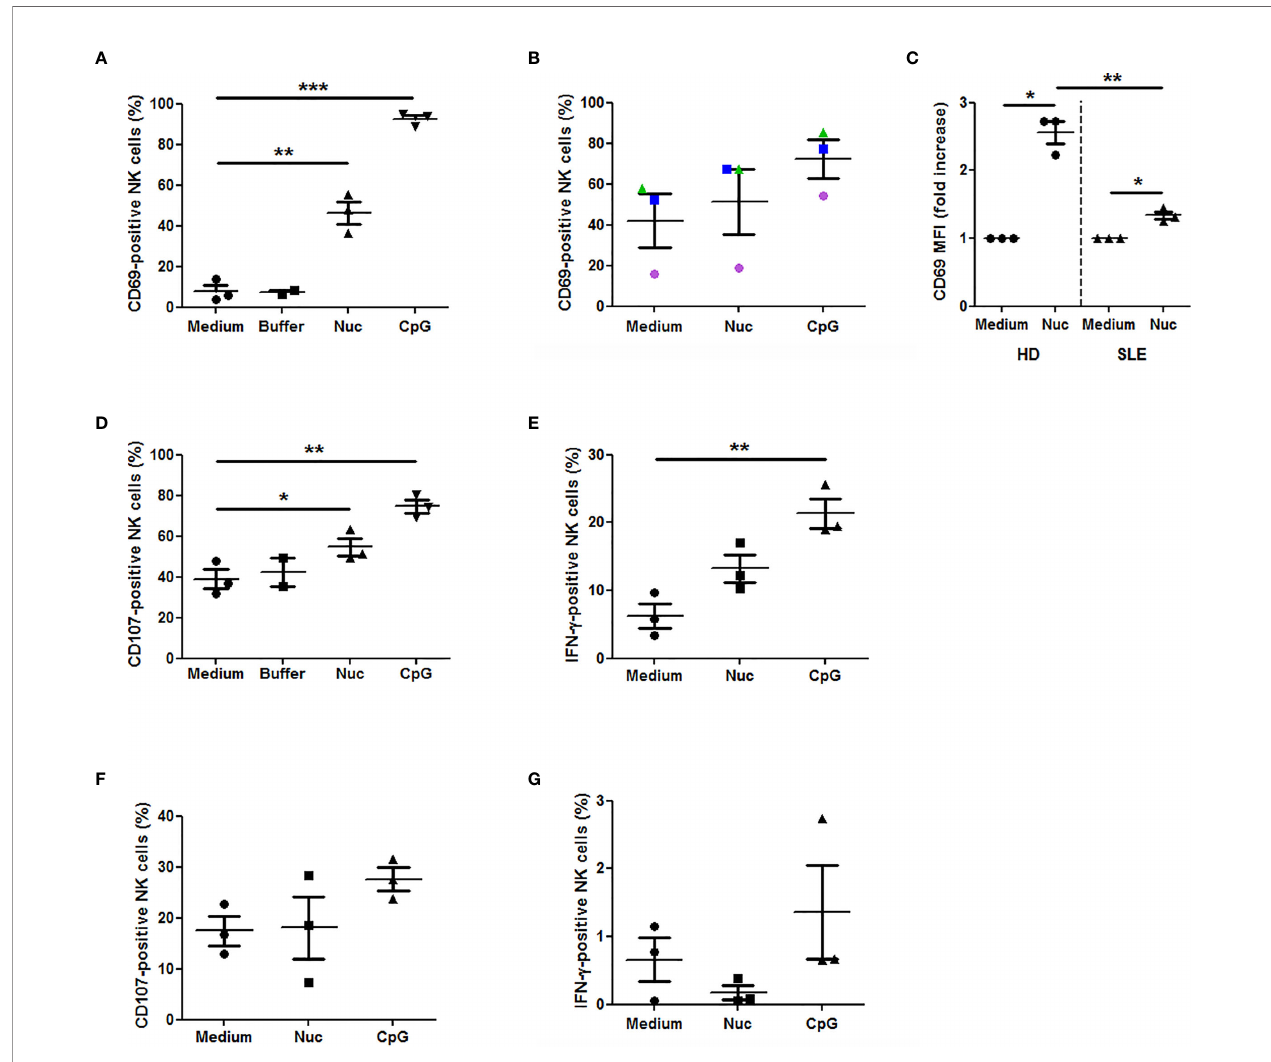
FIGURE 7 | Extracellular chromatin triggers NK cell activation in PBMC. PBMC were isolated from healthy individuals (n = 3, A, C – E ) or SLE patients (n = 3, B, C, F, G ) and cultured in medium alone or supplemented with puri fi ed nucleosomes (Nuc, 25 µg/ml), its puri fi cation buffer or a TLR9 agonist (a synthetic oligonucleotide containing unmethylated CpG motifs, CpG). NK cell activation was analyzed by fl ow cytometry, gating on CD3 - CD56 + cells as in Supplementary Figure 2 . (A – C) CD69 expression by NK cells from healthy individuals (A, C) or SLE patients (B, C) . PBMC were cultured without K562 cells. The percentages of CD69-positive NK cells (A, B) or CD69 expression levels (C, mean fl uorescence intensity (MFI) normalized to non-stimulated cells) are depicted. (A) **p < 0.01; ***p < 0.001 (two-tailed paired t -test). (B) Circles, triangles and squares represent PBMC of an independent donor analyzed in the three culture conditions. (C) *p < 0.05 (one sample t -test); **p < 0.01 (two-tailed unpaired t -test). (D) CD107 expression by NK cells from healthy individuals. PBMC were cultured in the presence of K562 target cells. *p < 0.05; **p < 0.01 (two-tailed paired t -test). (E) IFN- g production by NK cells from healthy individuals. PBMC were cultured in the presence of K562 target cells. **p < 0.01 (two-tailed paired t -test). (F) CD107 expression by NK cells from SLE patients and analyzed as in (D) . (G) IFN- g production by NK cells from SLE patients, analyzed as in (E) . Shown are pooled data from six independent experiments using PBMC from six independent donors. Each panel shows pooled data from either three independent healthy donors (HD) or three independent SLE patients, using fi ve independent nucleosome preparations. Mean and SEM are depicted. The percentages of cells positive for the marker of interest or CD69 normalized levels among NK cells are